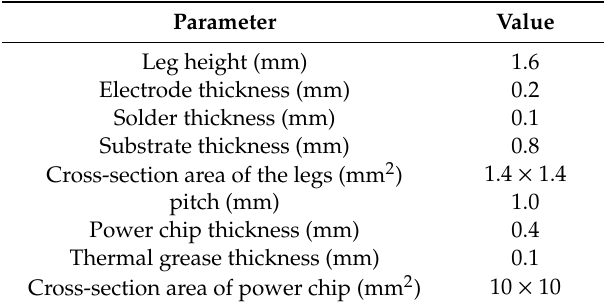
Figure 2. Geometric model of a thermoelectric pair: ( a ) rectangular TEC or ( b ) trapezoidal TEC. Table 1. Basic geometric parameters of the rectangular